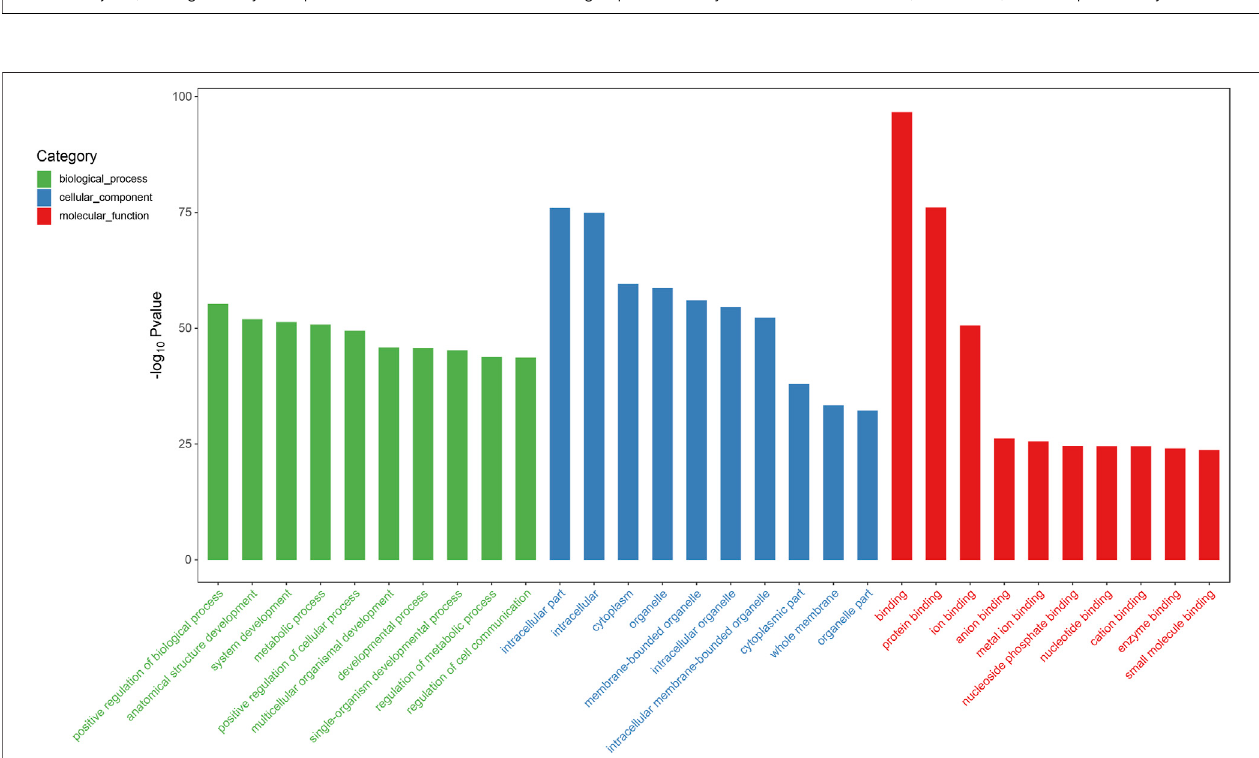
FIGURE 4 | Top 10 signi fi cant enriched GO terms analysis of circRNAs. Differentially expressed circRNAs were mainly involved in biological process, cellular component,andmolecularfunction.Eachplotrepresentsaspeci fi cbiologicalfunction,andthelargerthesize,thestrongerthecircRNAsexpression.Comparedwiththe normal subjects, the signi fi cantly over-presented circRNAs in the CRSwNP group were mainly involved in cell adhesion, membrane, and receptor activity.